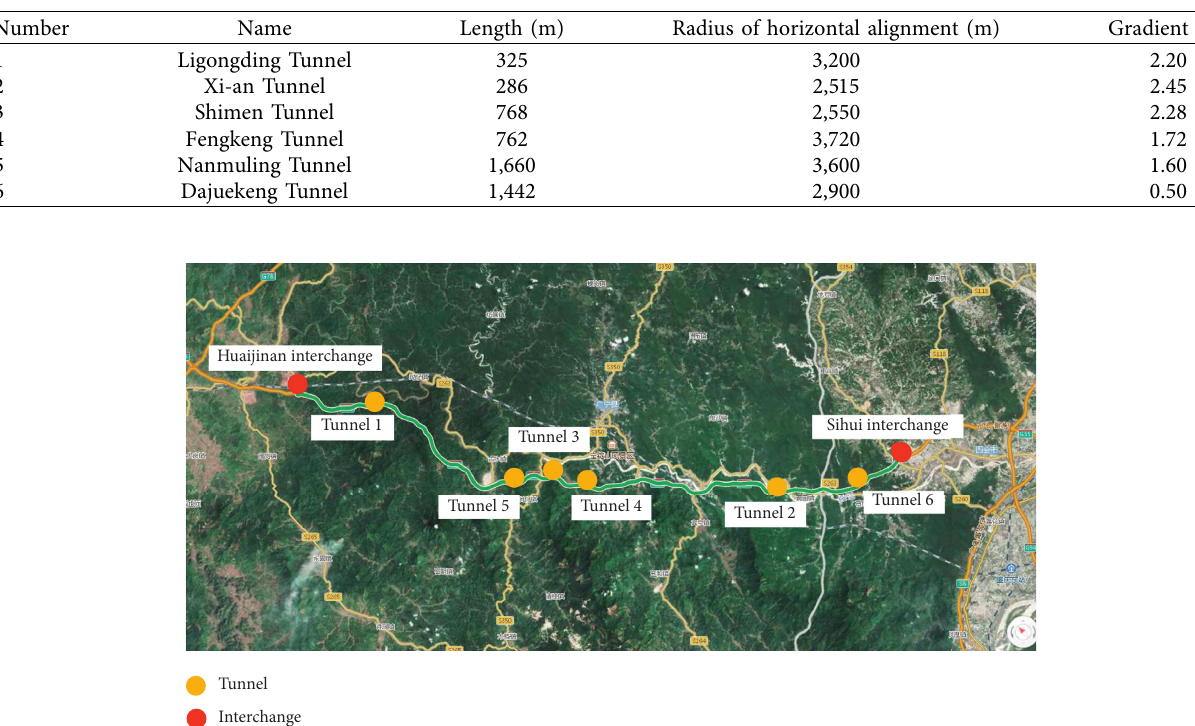
Table 1: Test tunnel data.